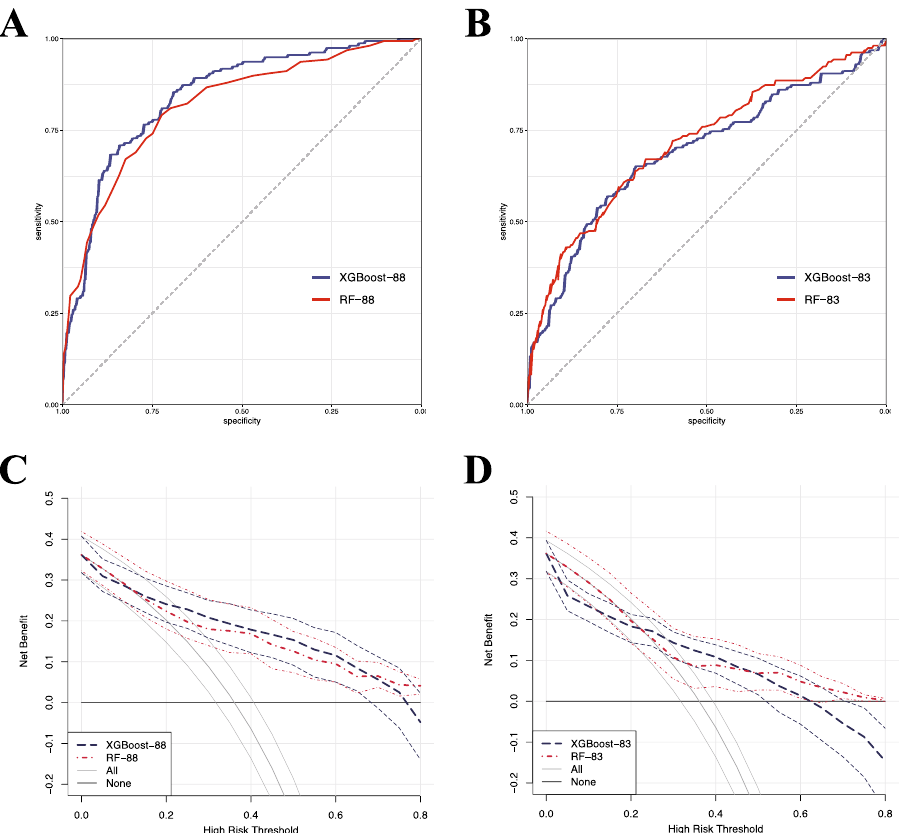
Figure 2. Receiver operating characteristic (ROC) curves and decision curve analysis (DCA) results in the testing set. ( A,B ) ROC curves of XGBoost and RF models based on 88 features and 83 features, respectively. ( C,D ) DCA for classifying DKD in T2DM patients by machine learning (ML) models based on 88 features and 83 features, respectively. The net benefit and 95% confidence interval for the ML models are shown with blue and red dashed lines. Two extreme strategies, classifying for all and classifying for none, are represented by solid grey and solid black